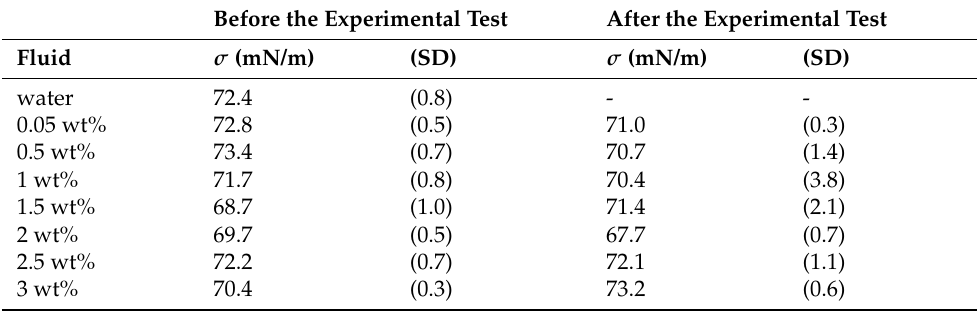
Table 5. Mean surface tension of all working fluids at a temperature of 20 ◦ C. Before the Experimental Test